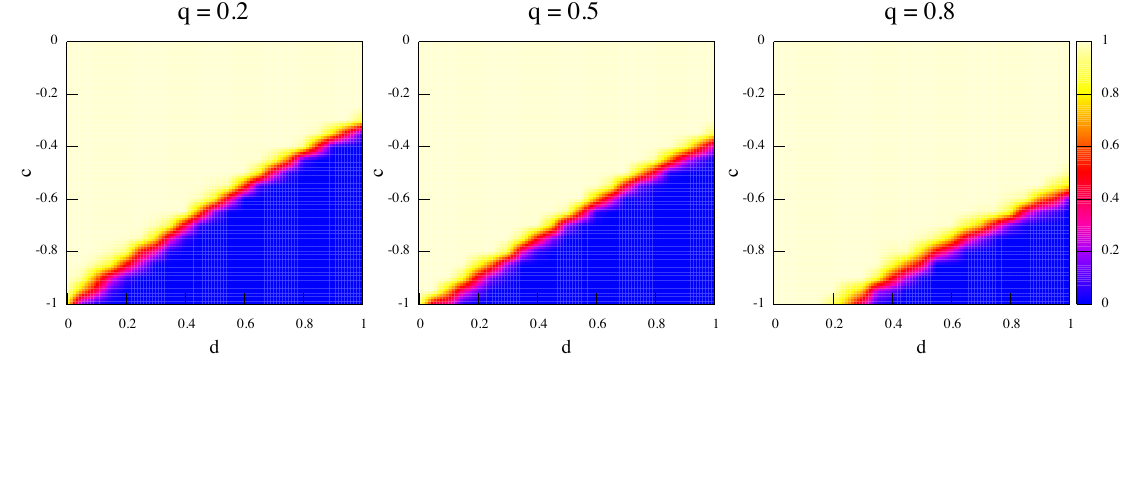
Figure 7. Average strategy proportions over 50 independent runs in the game’s phase space at steady state. Initially α and β are equally represented. Update rule is replicator dynamics and rewiring frequency q increases from left to